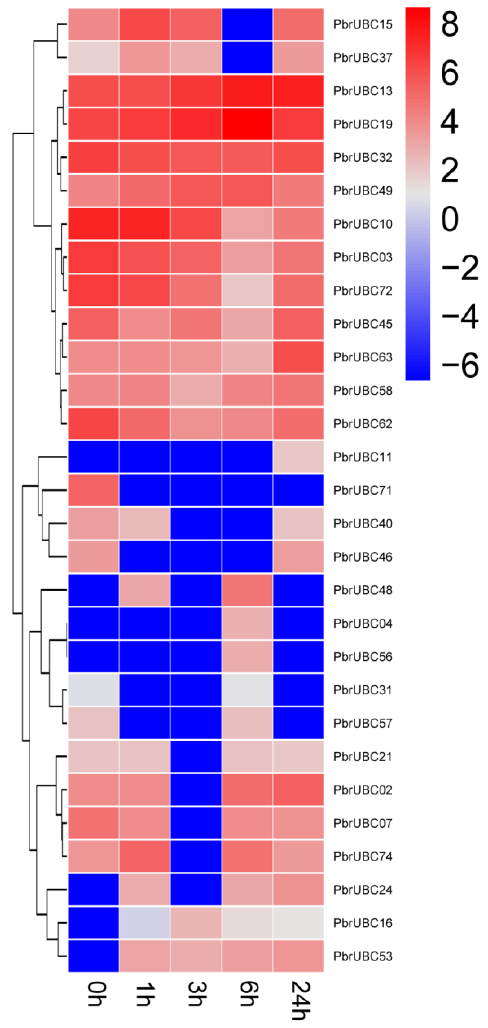
Figure 6. Expression analysis of PbrUBC genes under drought stress treatment. The color scale represents normalized log 2 ‐ transformed, where grey indicates a medium level, blue indicates a low level, and red indicates a high level. The treatments were indicated at the bottom of each column, and the genes are located on the right.